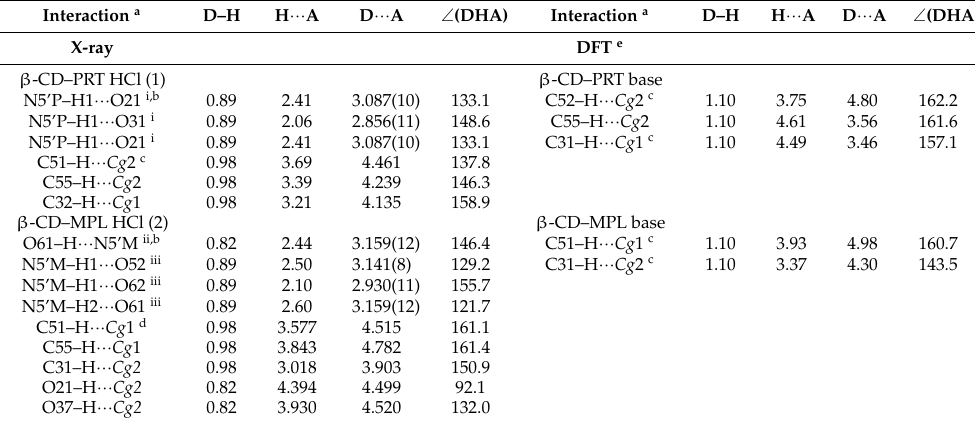
Table 3. Selected host–guest interactions in the β -CD–PRT and β -CD–MPL inclusion complexes deduced from X-ray analysis and DFT full-geometry optimization (Å, ◦ ). Interaction